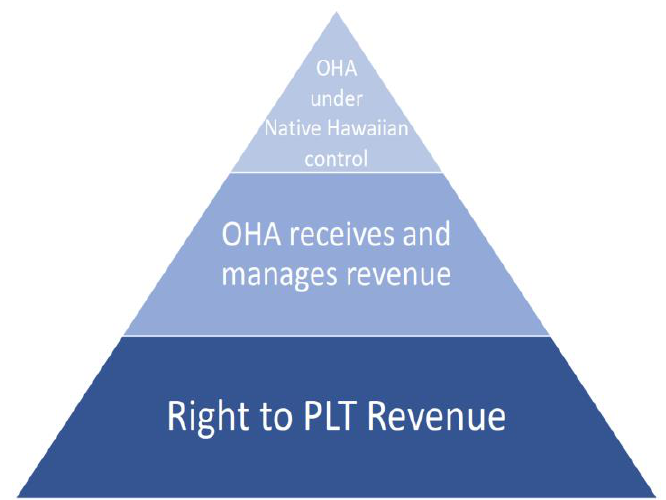
Figure 1. PLT three-part structure.